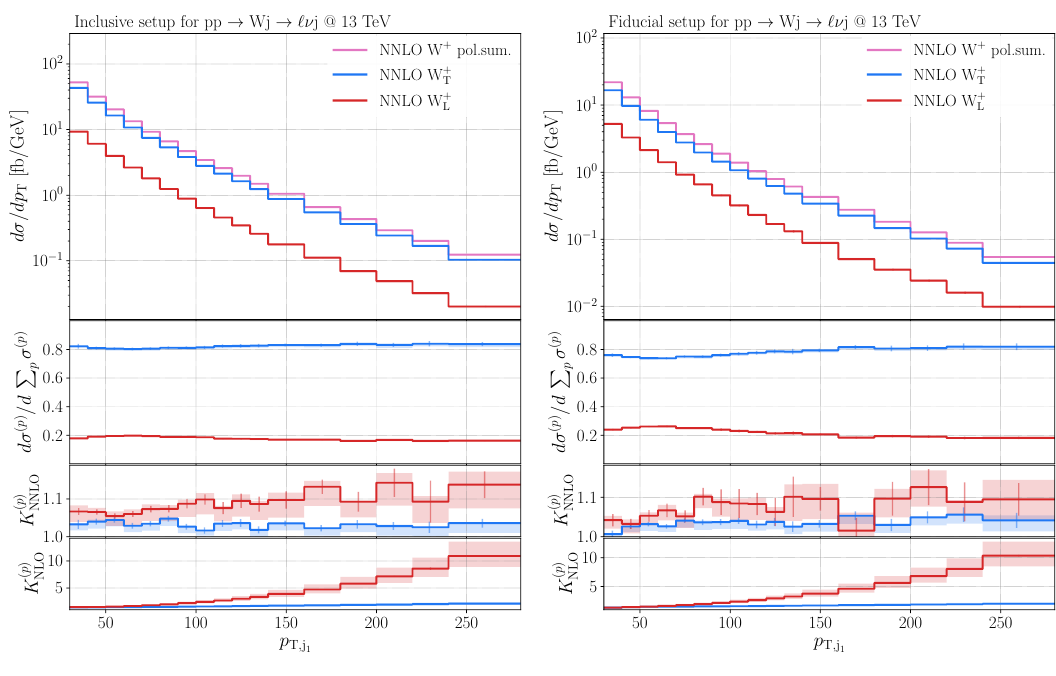
. Same plot structure as in figure 2. 1